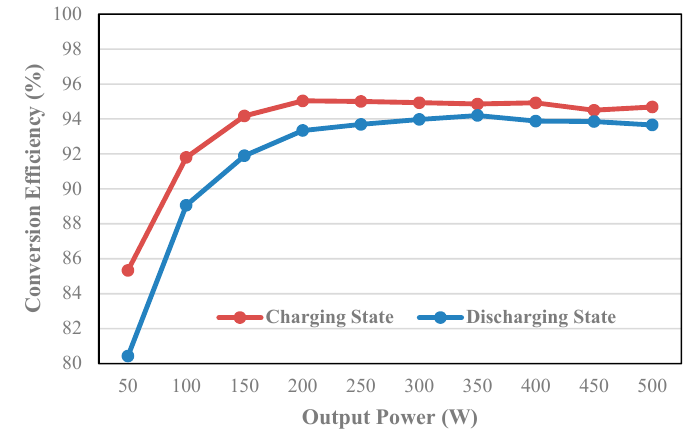
Figure 13. Conversion efficiency curves of the developed system for nominal voltage V bat = 48 V and DC-bus voltage V bus = 400 V under different loads.